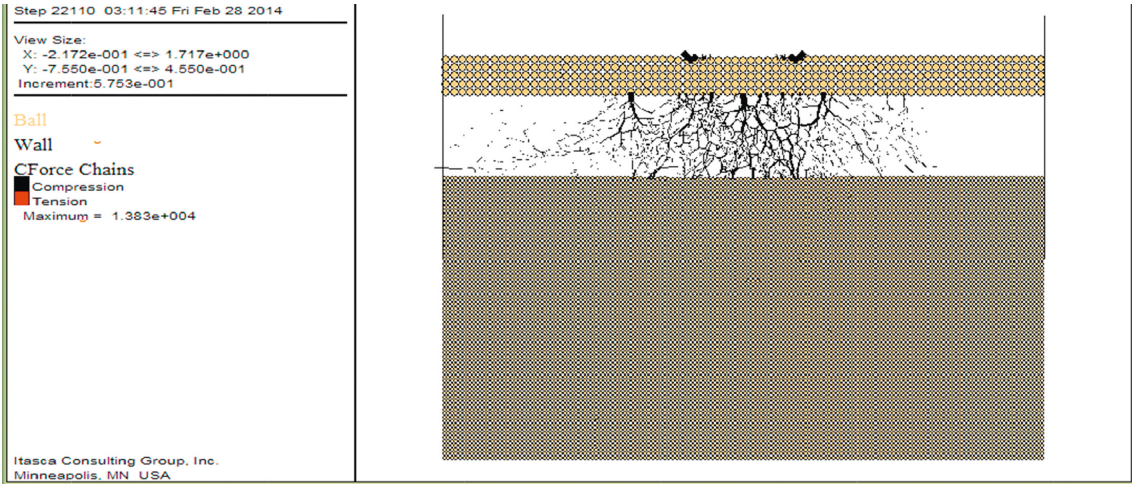
Figure 5: Stress distribution of graded aggregate base layer (black and red denote pressure and tension, resp.).